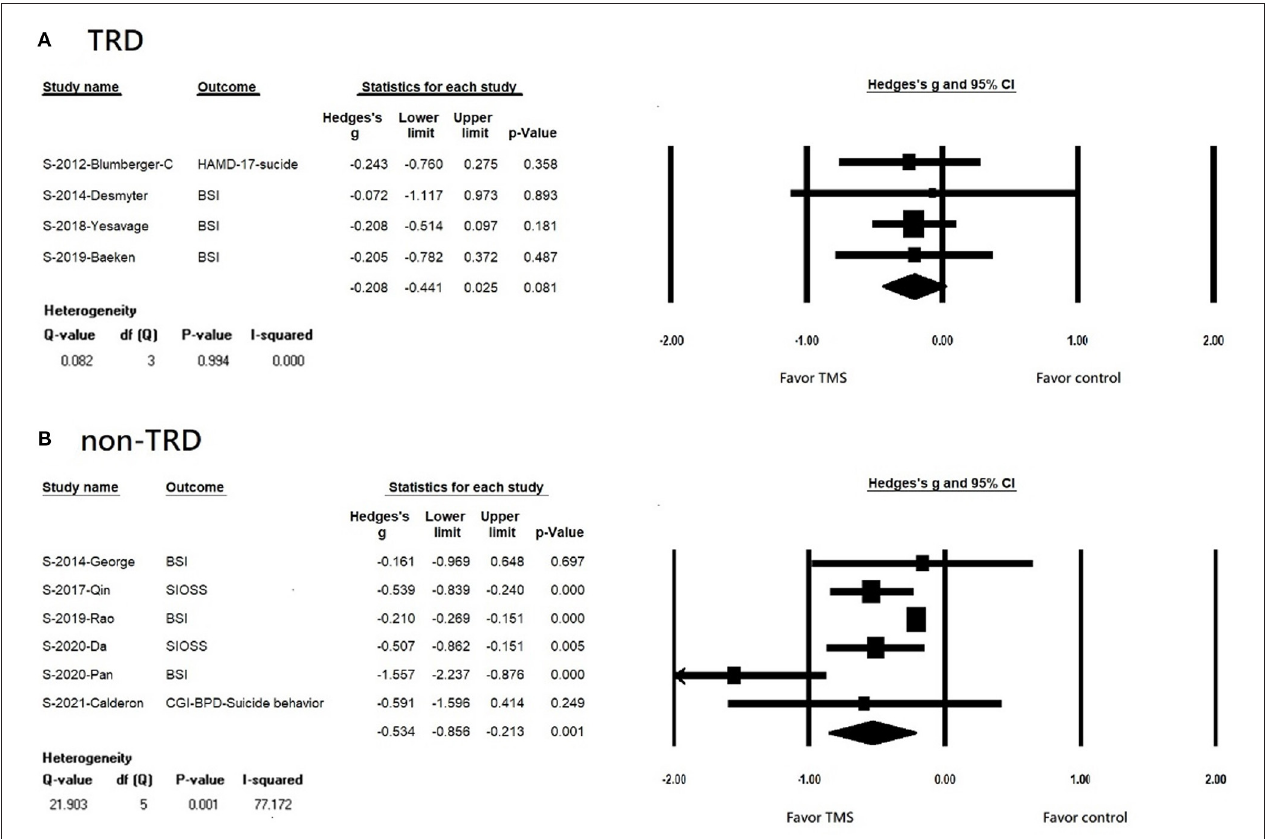
FIGURE 3 | (A) Forest plot of meta-analysis of improvement of suicidal ideation in patients with TRD receiving repetitive transcranial magnetic stimulation treatment and in those with control treatment. (B) forest plot of meta-analysis of improvement of suicidal ideation in patients with non-TRD receiving repetitive transcranial magnetic stimulation treatment and in those with control